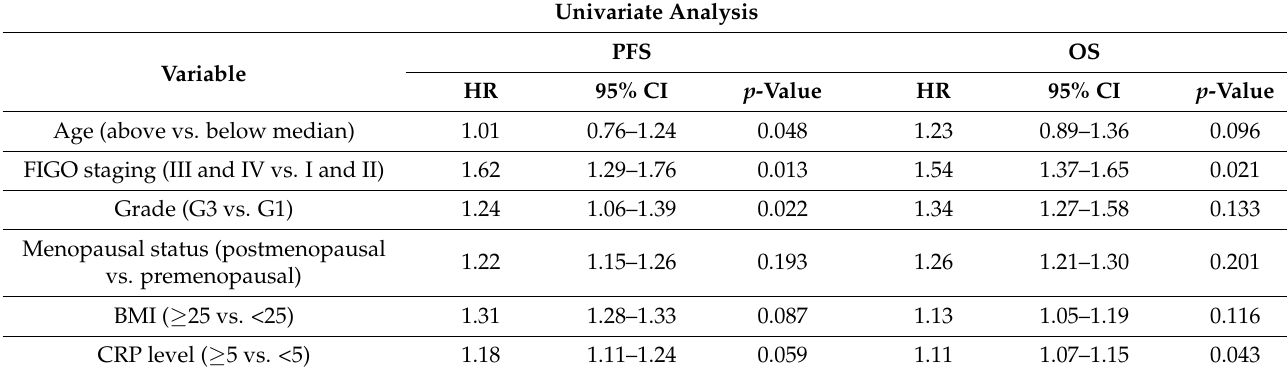
Table 8. Univariate and multivariate Cox regression model for PTX3 serum